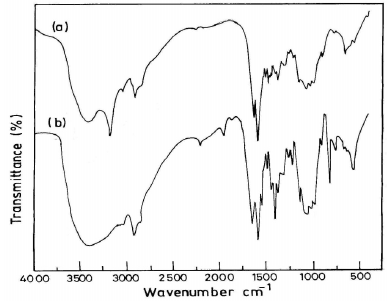
Figure 1. FTIR of (a) Chitosan, (b) chitosan- g -poly(4-vinylpyridine) copolymer 80% G.